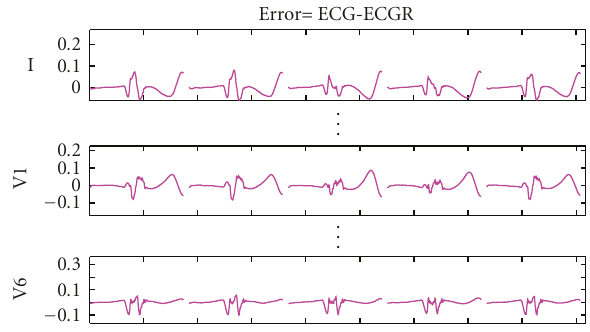
Figure 7: Example of a patient with sinus rhythm: real ECG channels.